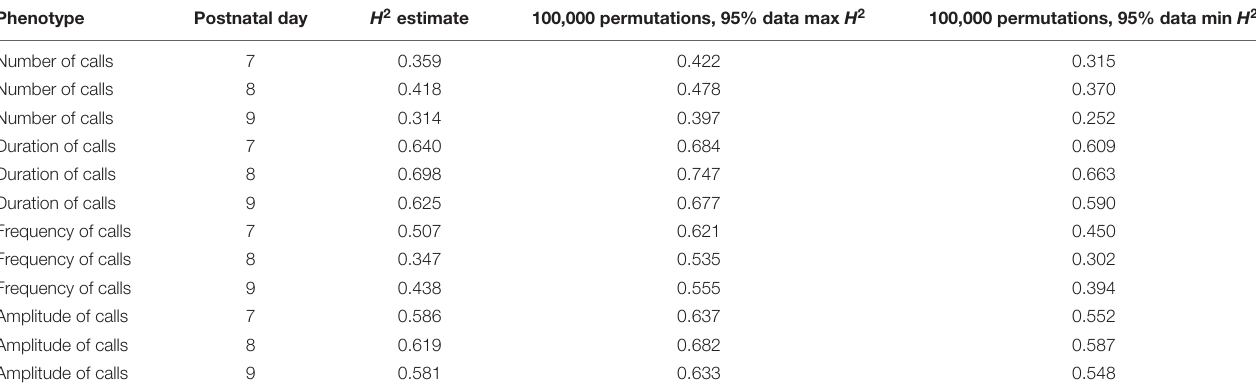
TABLE 4 | Heritability estimates for quantitative traits in the BXD population, measured on postnatal days 7, 8, and 9.